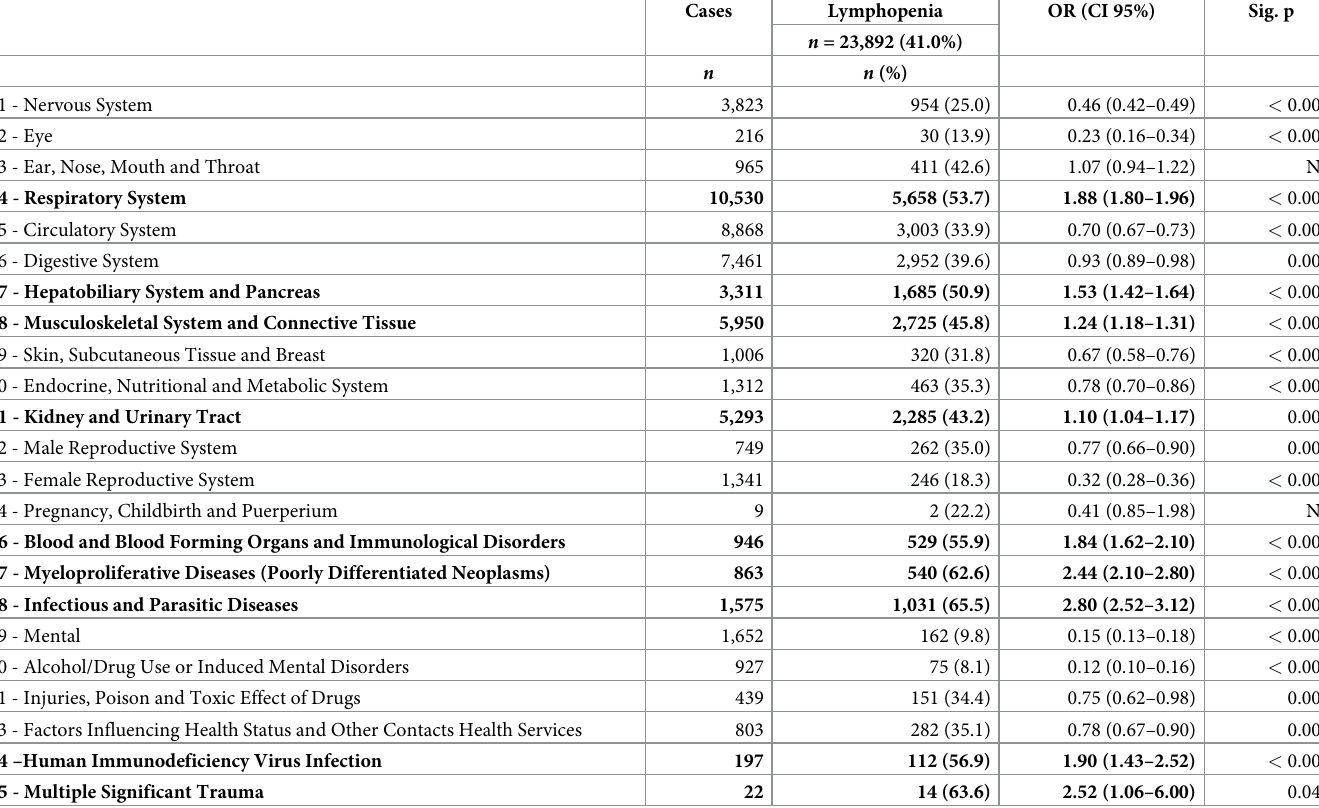
Table 2. Relationship of lymphopenia according to Major Diagnostic Categories (MDC) ( n =